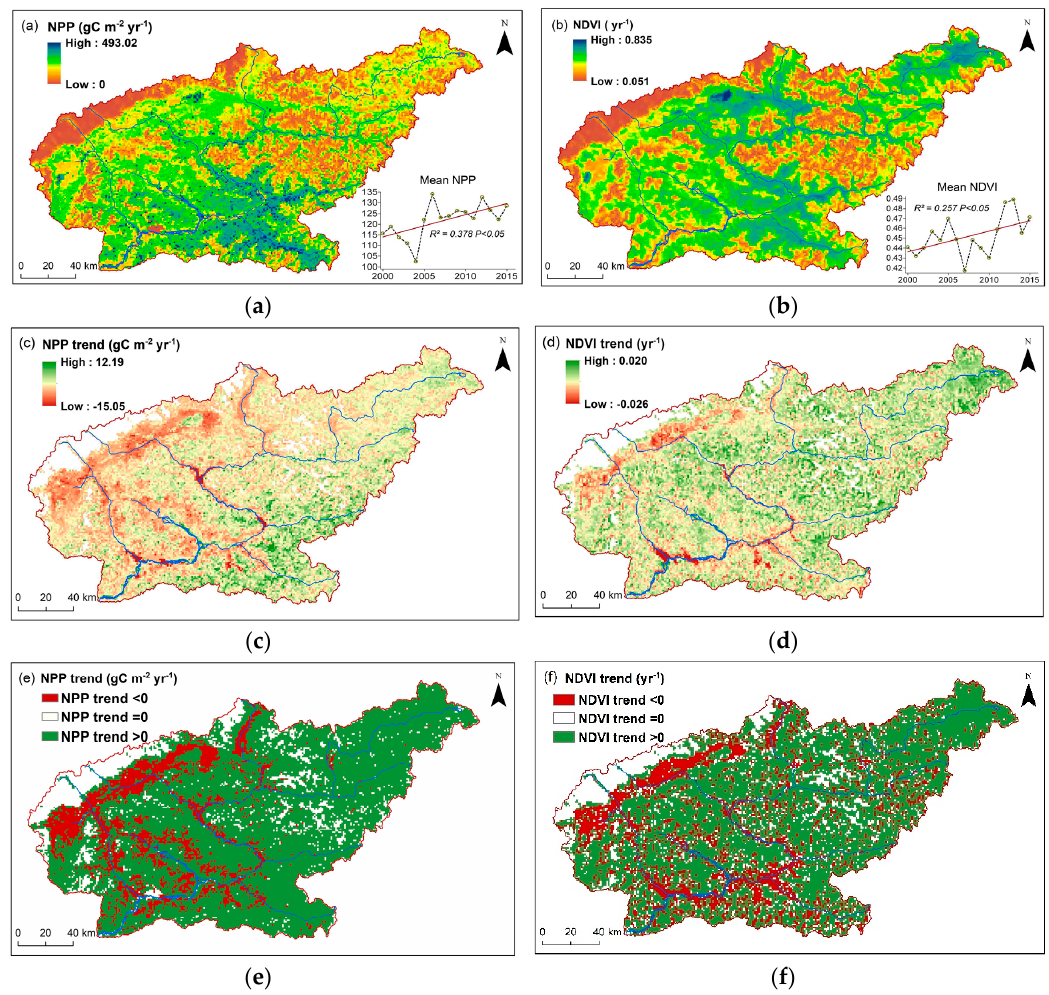
Figure 2. Spatial and temporal distributions of NPP, NDVI and their trends from 2000-2015: ( a ) annual mean NPP, ( b ) annual mean NDVI, the line charts indicate the annual variation in the spatially averaged values; ( c ) changing trend of NPP, ( d ) changing trend of NDVI, the white pixels represent the NOC areas; ( e ) qualitative classification of NPP trend, ( f ) qualitative classification of NDVI trend.